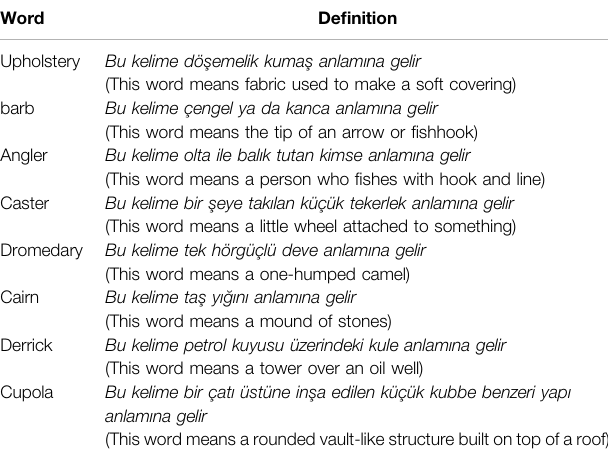
TABLE 1 | The target words and their de fi nitions used in the study.